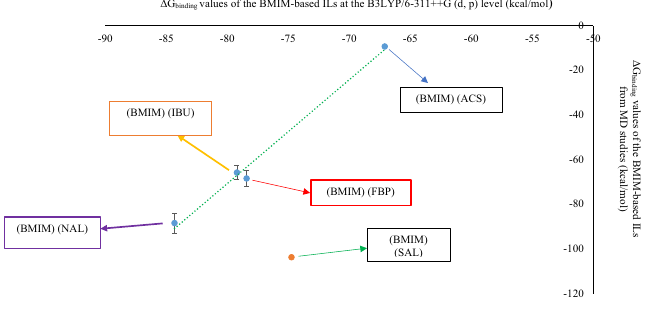
Figure 8. The relationship between the QM ΔG binding (kcal mol −1 ) and MD ΔG binding (kcal mol −1 ) for following BMIM-based ILs: (BMIM) (ACS), (BMIM) (FBP), (BMIM) (IBU), and (BMIM) (NAL), (error bar % =